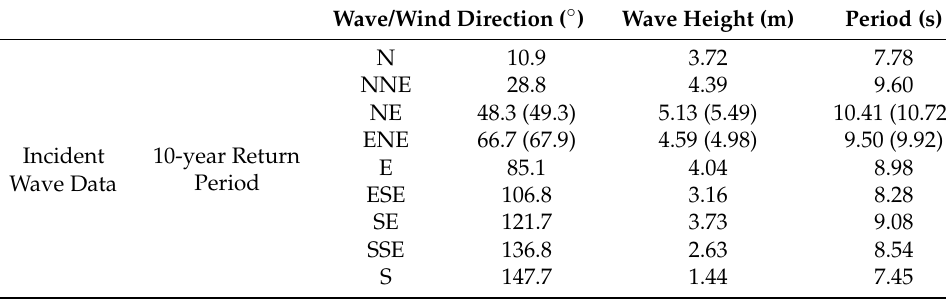
Table 2. The specifications of deep-water design wave for running the SWAN model.